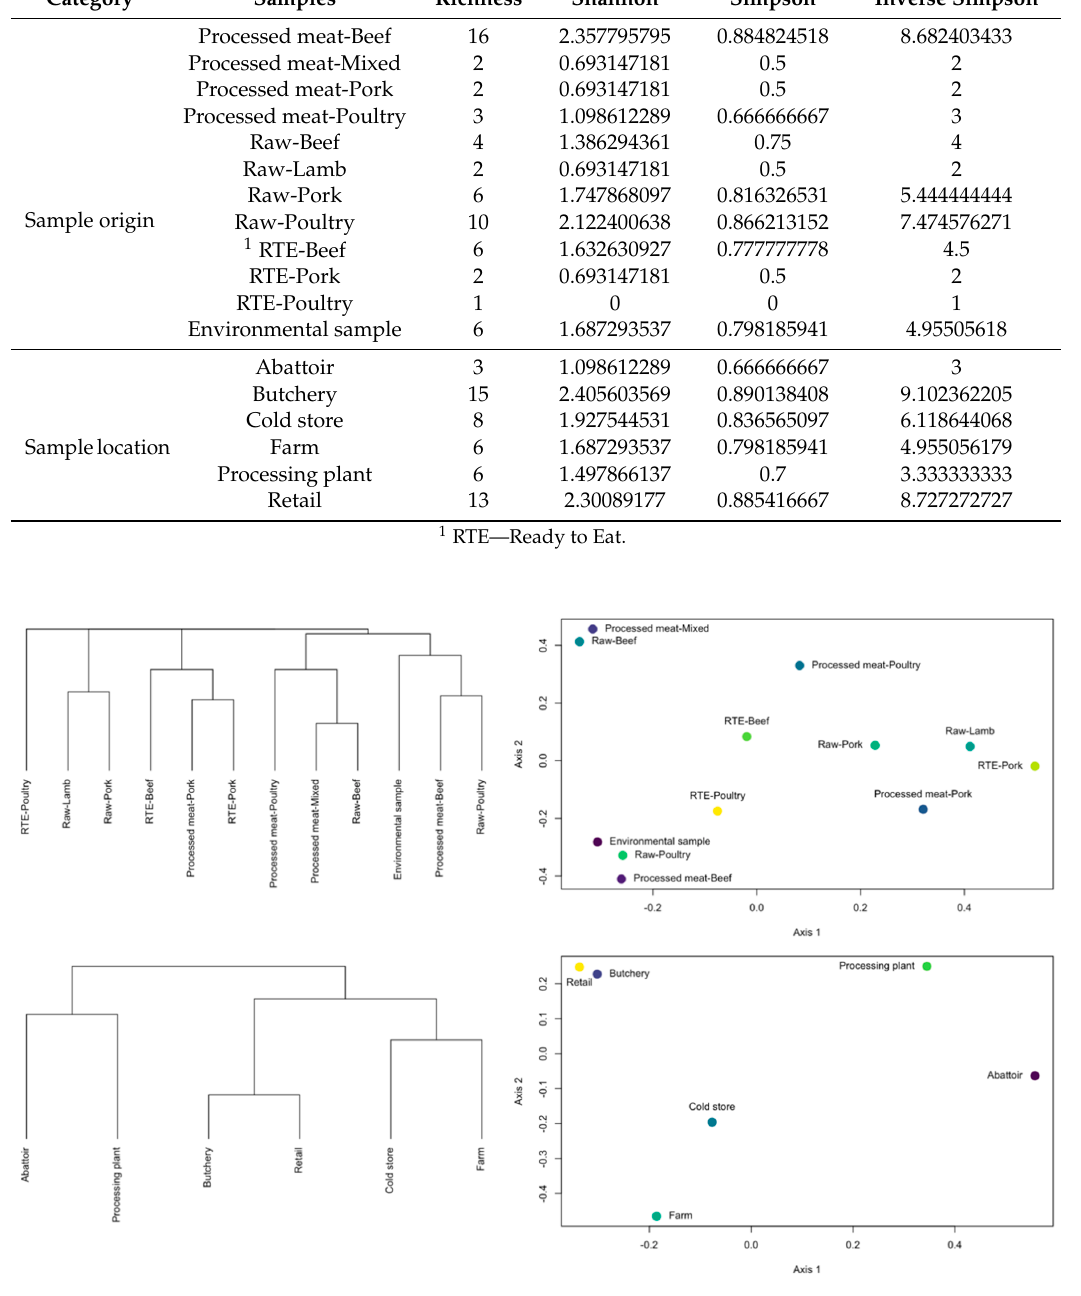
Figure 5. Hierarchical clustering dendograms and Principle coordinates analysis for the different sample categories .